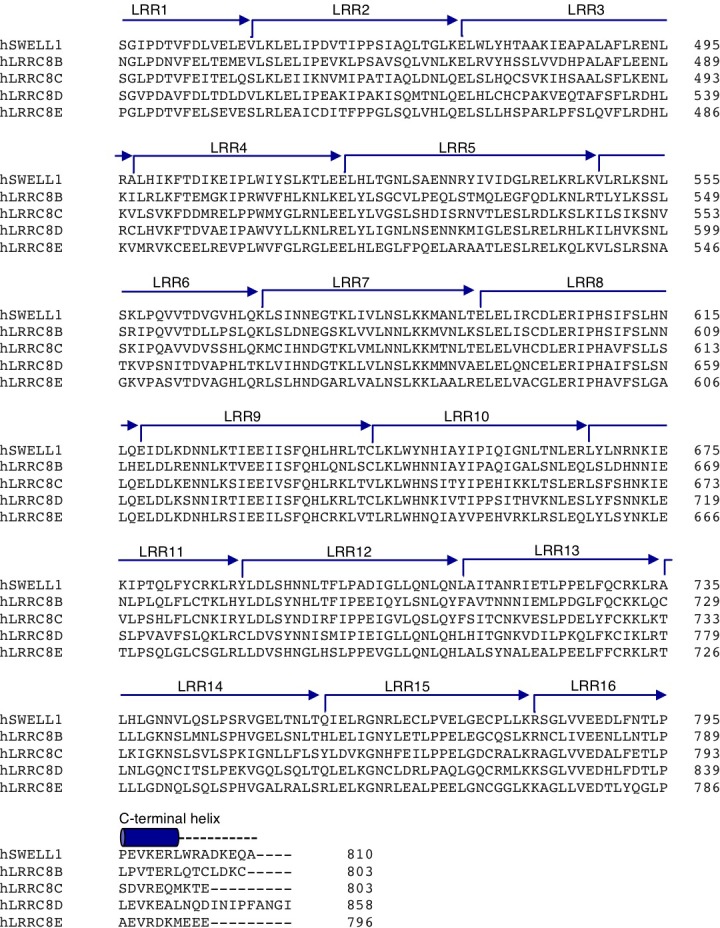
Alignment of LRRC8 subunits (res 436–810).Human LRRC8 family aligned using ClustalW. Secondary structure and domain assignments are annotated above. Residues mentioned in text are boxed red.